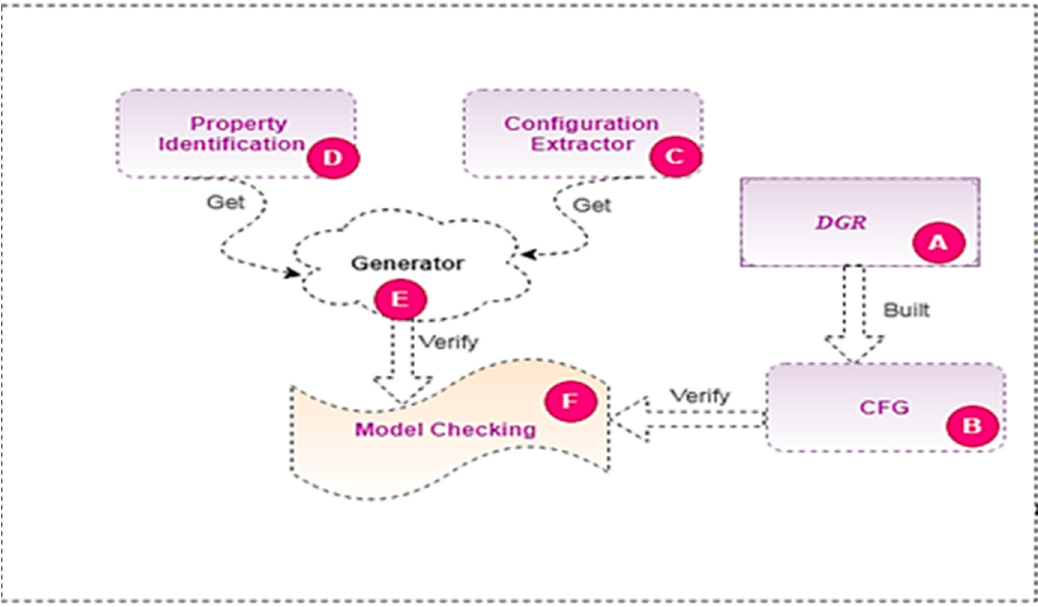
Figure 8. The dynamic analysis phase in the HSAS-MD.